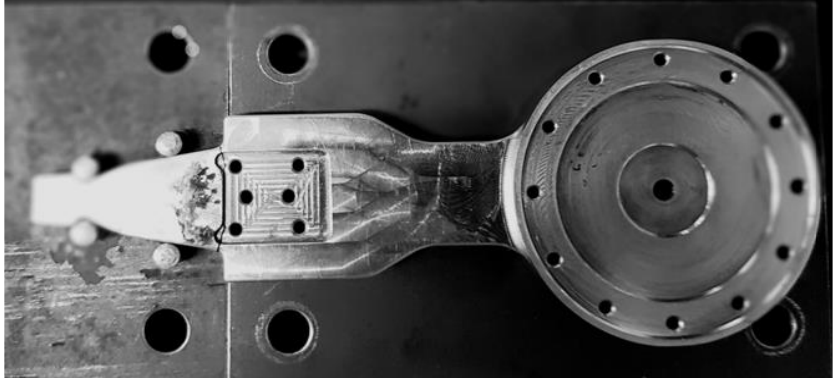
Figure 21. The breaking zone of the tested sample.